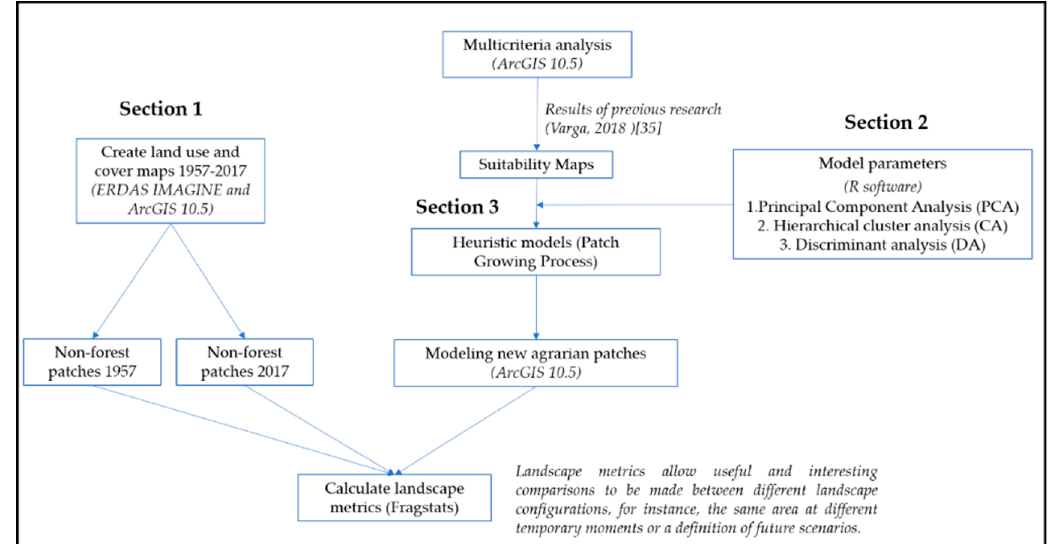
Figure 2. Methodology flow.